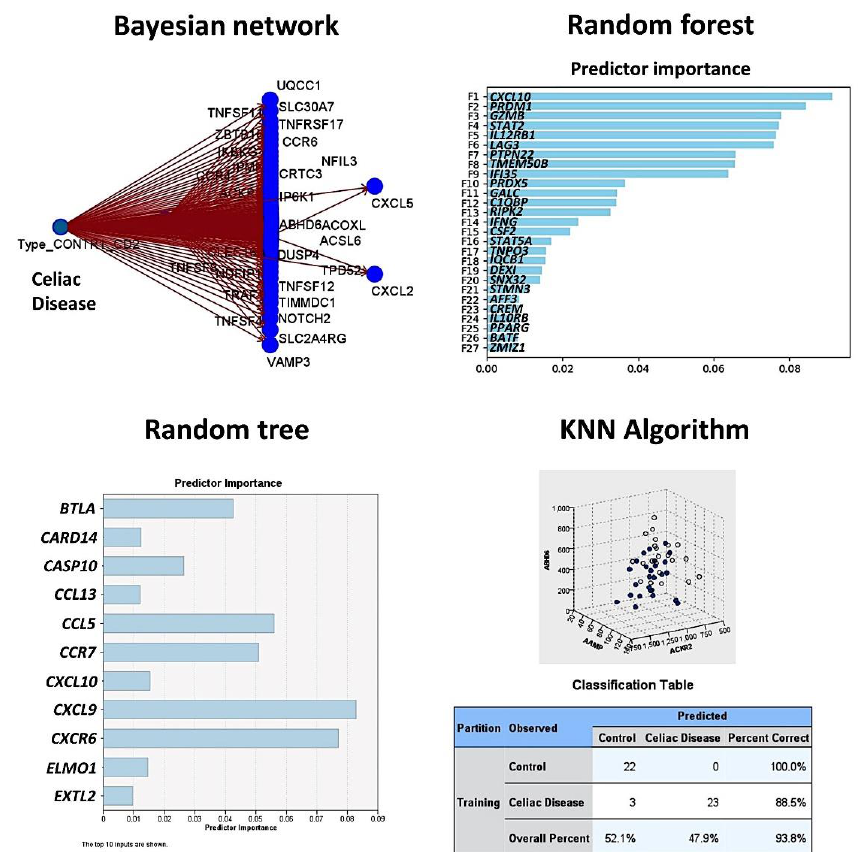
Figure 4. Prediction of celiac disease using the Bayesian network, random forest and tree, and the KNN algorithm. This figure shows the results of the modeling of celiac disease using the autoimmune discovery panel. The Bayesian network shows the genes (nodes) and the probabilistic, or conditional, independencies between them. The causal relationships may be represented, but the links (arcs) of the network do not necessarily represent direct cause and effect. The random forest plot and tree show the genes of the model, ranked according to their predicted importance. The KNN chart is a lower-dimensional projection of the predictor space, which contains 737 predictors (genes of the autoimmune discovery panel).